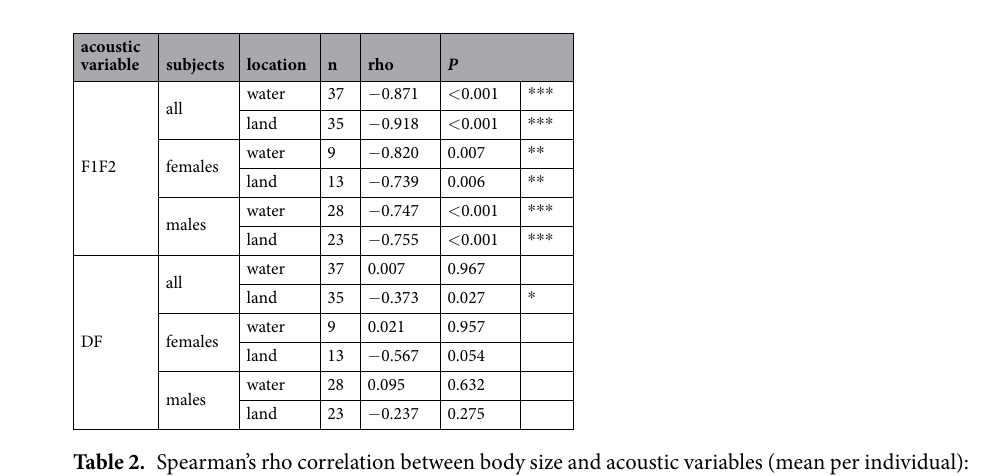
Table 2. Spearman’s rho correlation between body size and acoustic variables (mean per individual): coefficients and significance levels. F1F2 = Spacing between 1 st and 2 nd formant, DF = Dominant